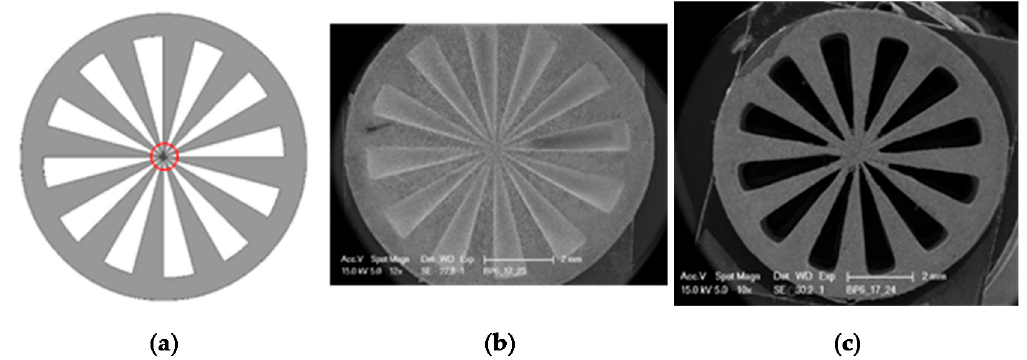
Figure 5. Siemens star, diameter 9 mm: ( a ) stl file used for the study; ( b,c ) SEM images of green bodies.